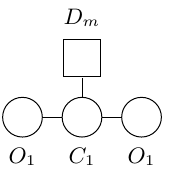
Figure 17 . Higgs branch quiver with D m global symmetry, dim M H